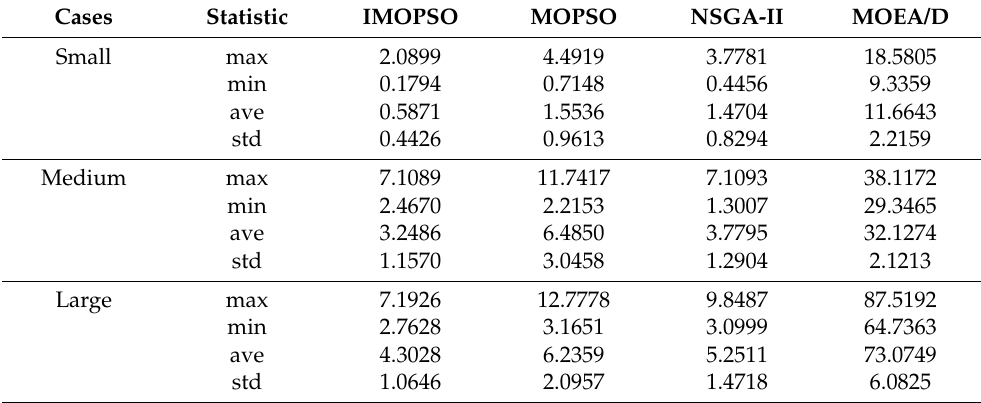
Table 5. Comparison of the IGD index of four